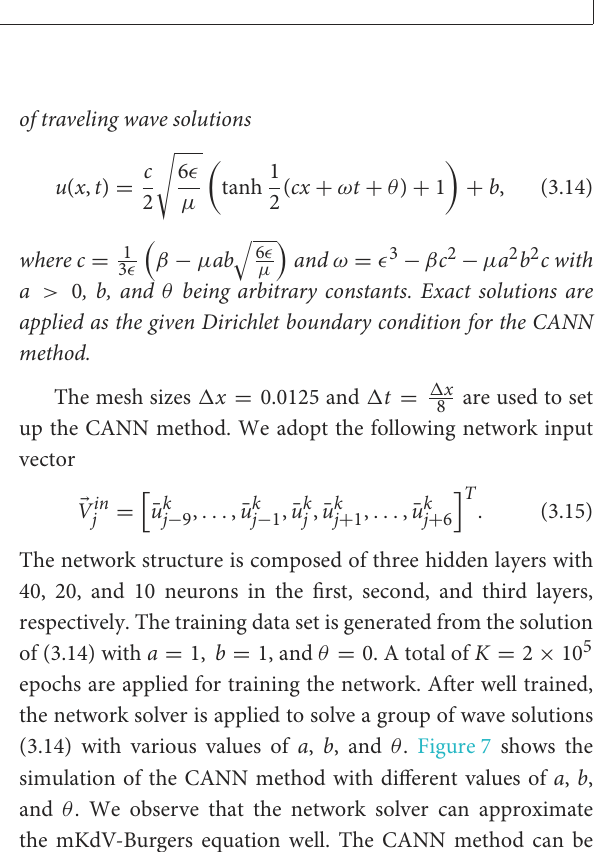
FIGURE15 Generalized fifth order KdV equation of Example 3.8: the CANN solution (red circles) and the exact solution (solid blue lines) at different time T with x 0 0 and λ = =